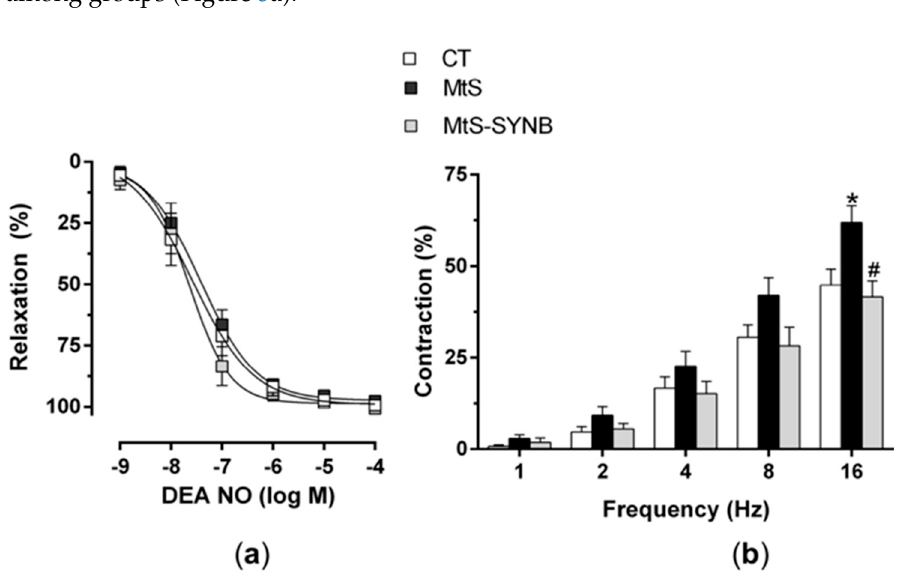
Figure 5. ( a ) Vasodilator response to DEA-NO in mesenteric segments from CT, MtS and MtS-SYNB rats. Results are expressed as % of relaxation elicited by NA (in mN: CT: 11.81 ± 1.1; MtS: 12.36 ± 1.03;